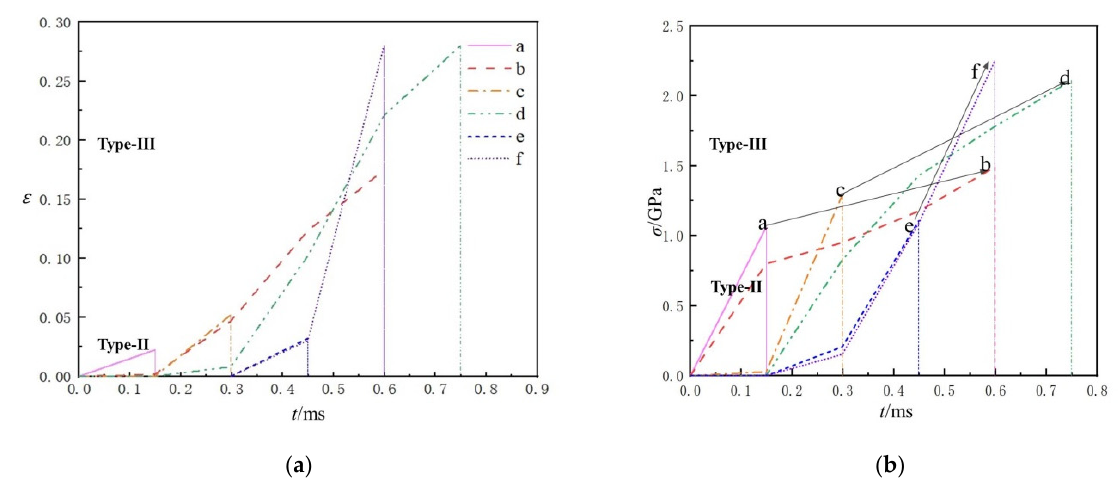
Figure 9. Stress and plastic strain curves at the marker pilot. ( a ) Variation of effective plastic strain; ( b ) Variation of effective strain.